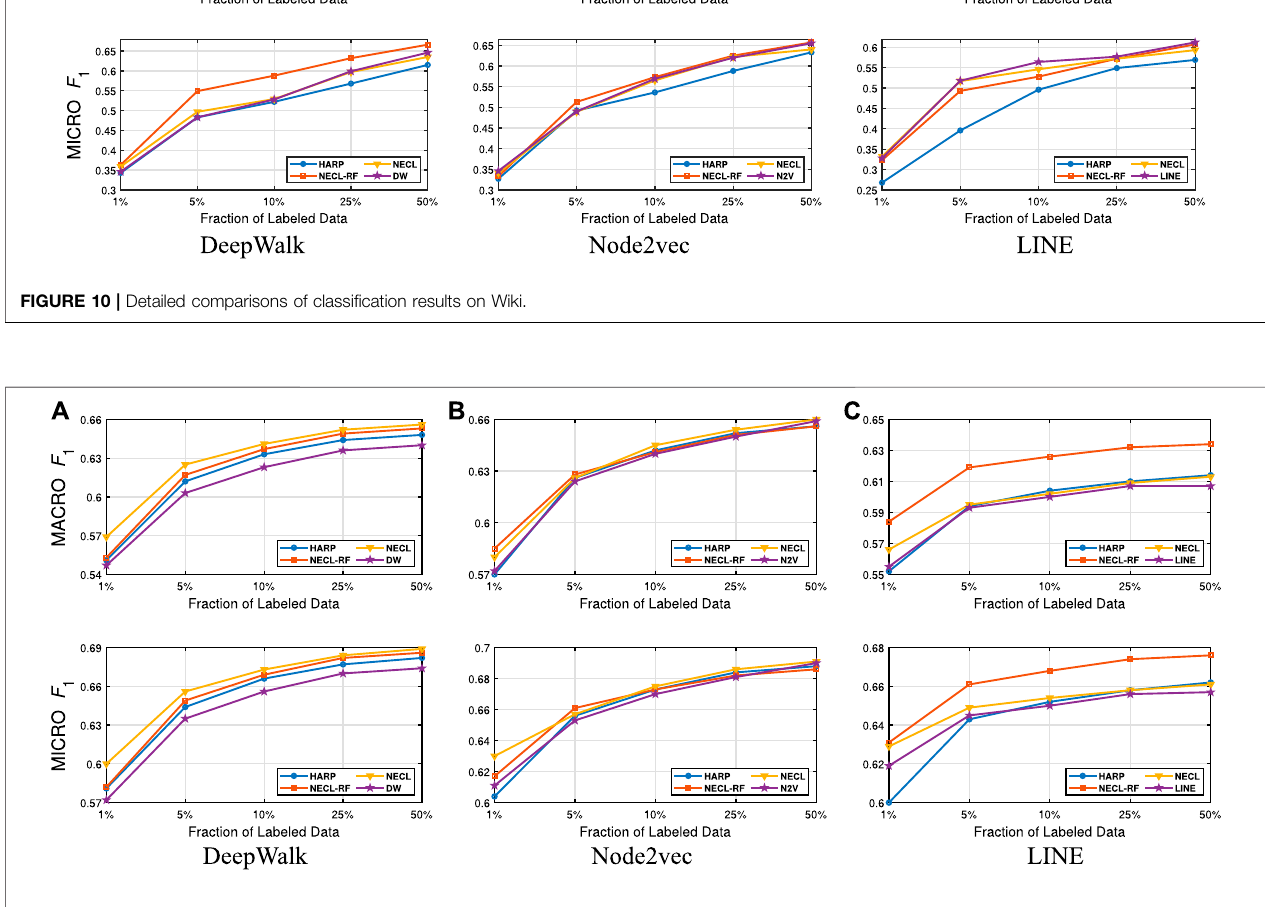
FIGURE 11 | Detailed comparisons of classi fi cation results on DBLP.